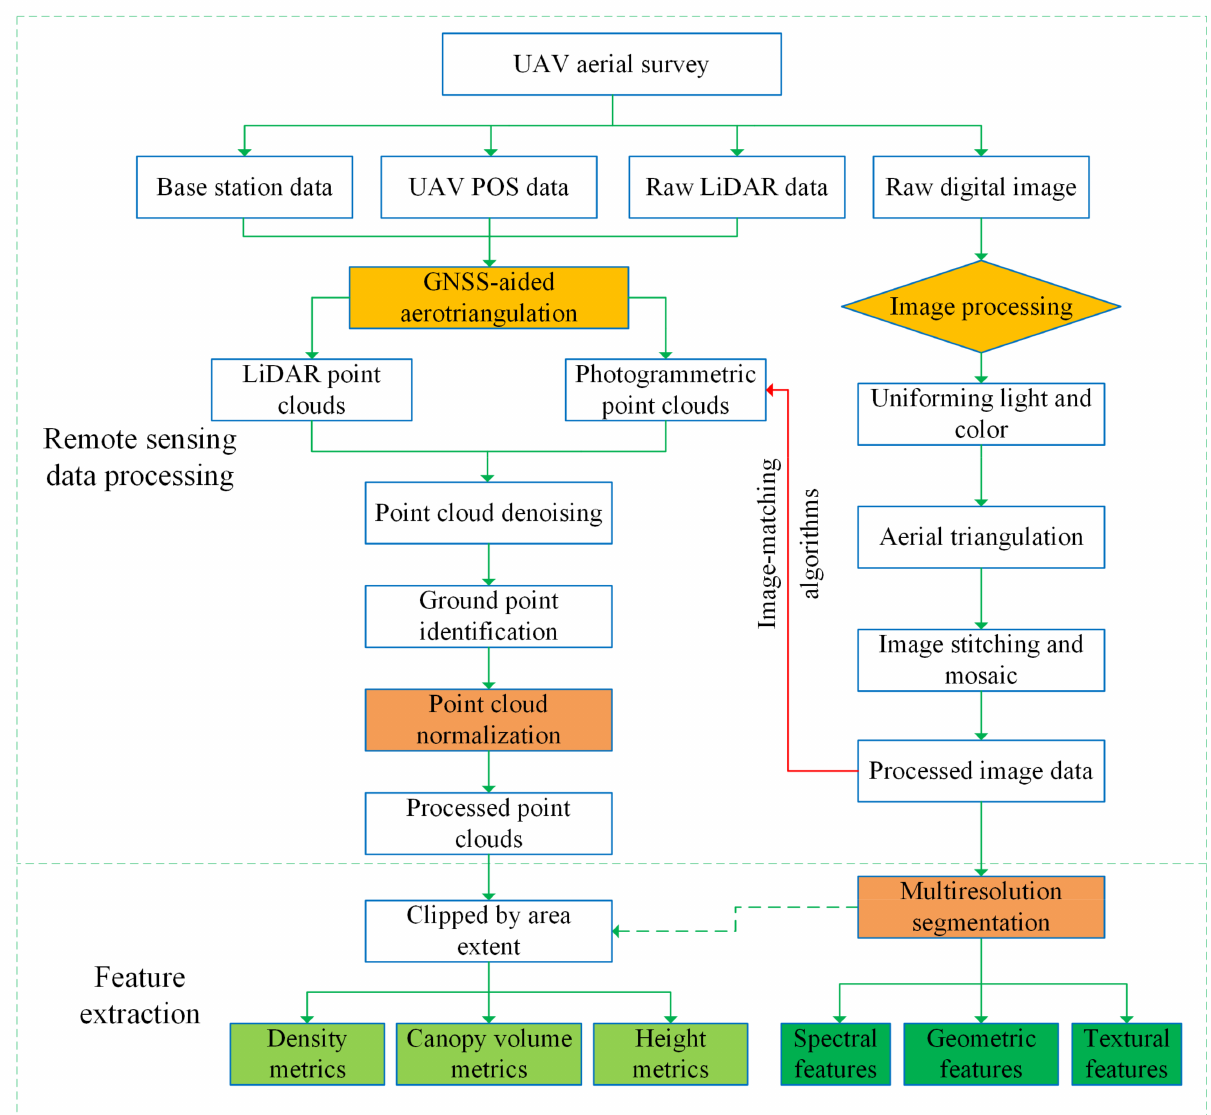
Figure 4. Workflow of the UAV data acquisition, processing, and feature